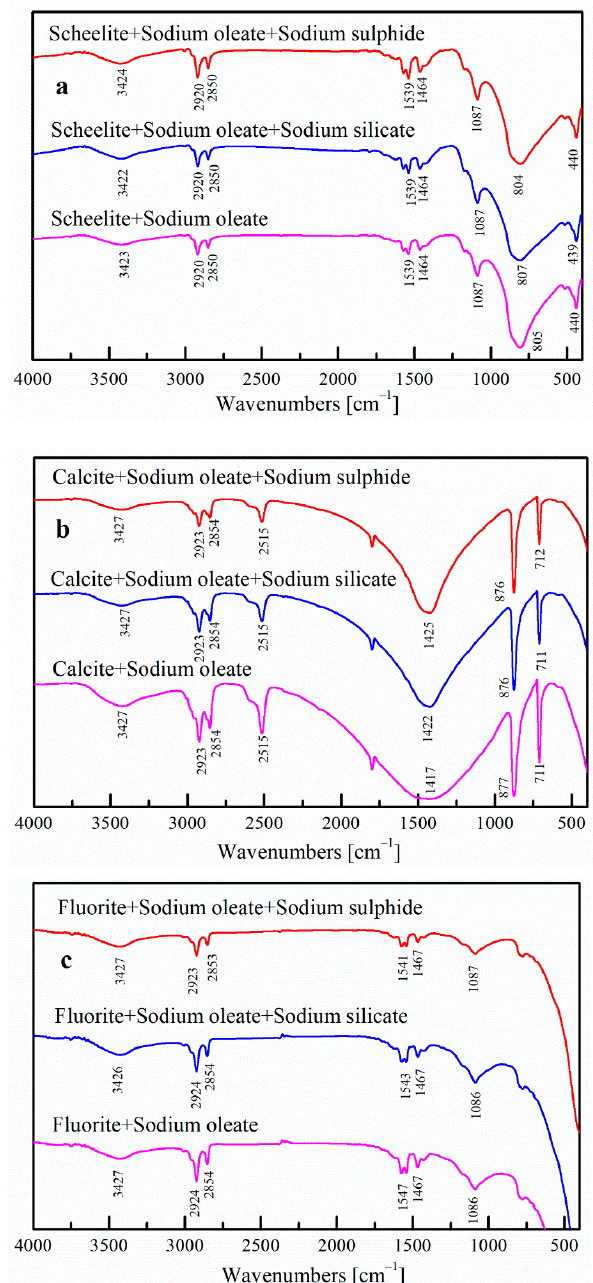
Figure 8. FTIR spectra of scheelite ( a ), calcite ( b ) and fluorite ( c ) after reaction with sodium oleate, sodium silicate or sodium sulfide.